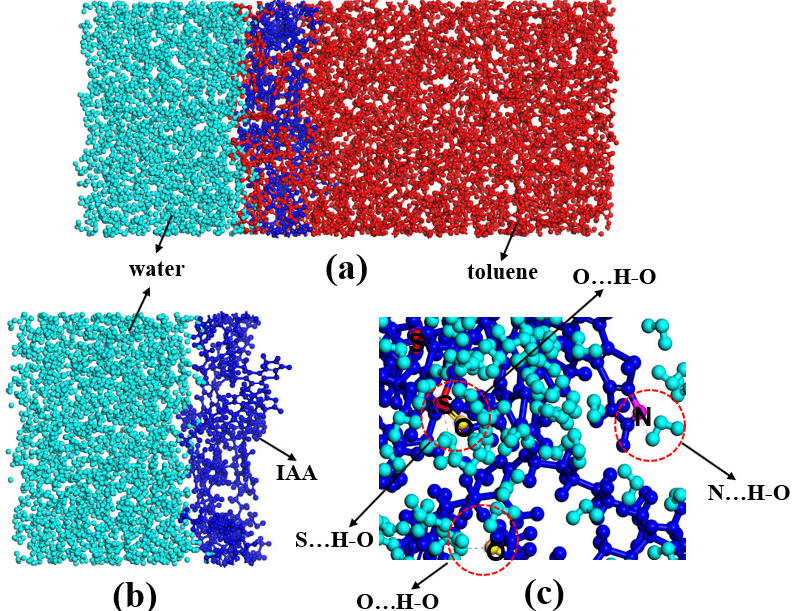
Figure 28. Interface system of IAA containing heteroatom (( a ): initial configuration, ( b ): display hydrogen bonds, ( c ): Partial enlarged view). Reprinted with permission from Ref. [208]. Copyright 2021, copyright with the Elsevier. More details on Copyright and Liscensing are available via the following link: https://www.sciencedirect.com/.